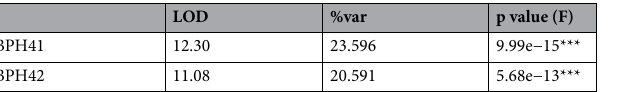
Table 1. QTLs detected for SWR66 × SWD10 F 2 mapping population. Significant codes: 0 ’***’ 0.001 ’**’ 0.01 ’*’ 0.05 ’.’ 0.1 ’ ’ 1.